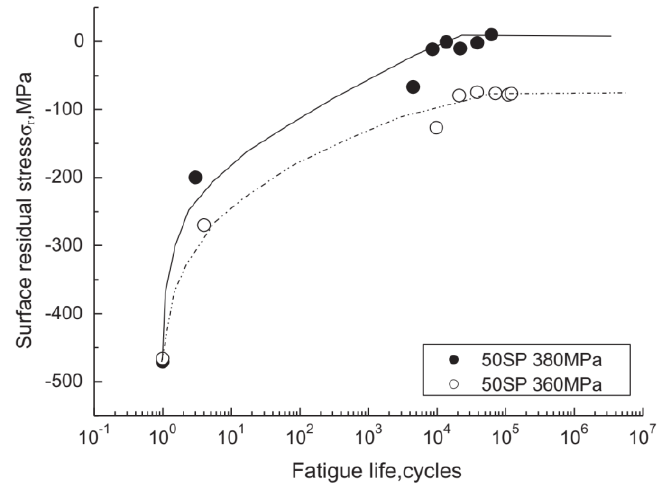
Figure 16. Comparison of compressive residual stress relaxation curves of microshot-peened 35CrMo and LZ50 steel specimens at relatively high fatigue stress levels compared to the material cyclic yield strengths. The specimens were subjected to rotary bending fatigue tests. Reprinted with permission from Ref. [13]. Copyright 2011 Elsevier.